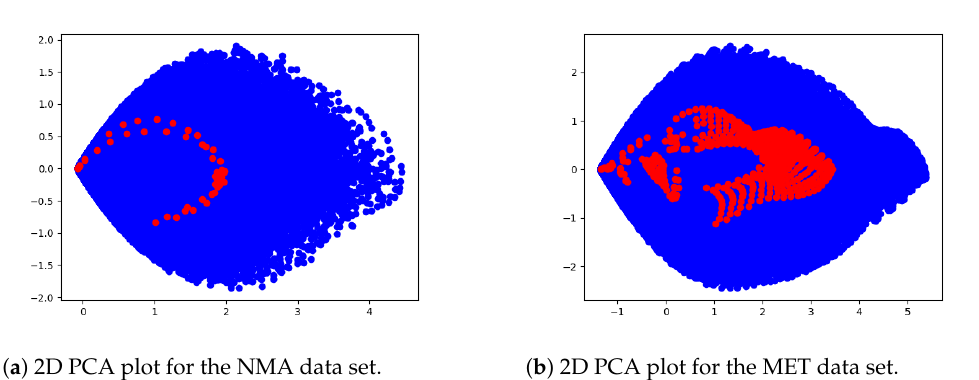
Figure 4. 2D PCA visualization of the NMA data set ( a ) and MET data set ( b